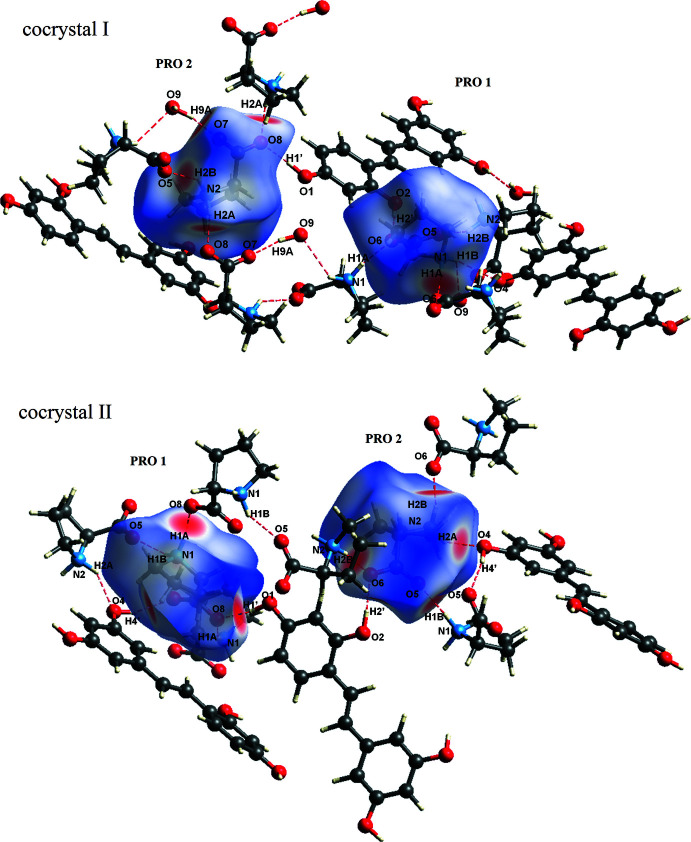
Hirshfeld surfaces of the PRO mol­ecules in (I) and (II).